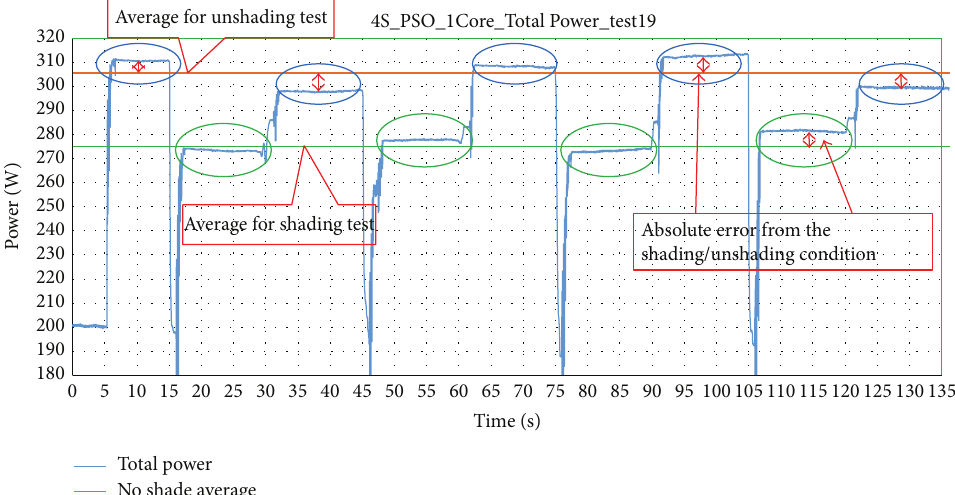
Figure 19: Benchmark value calculation for the shading and unshading condition for a PV test; the error is calculated from each of its shading/unshading test